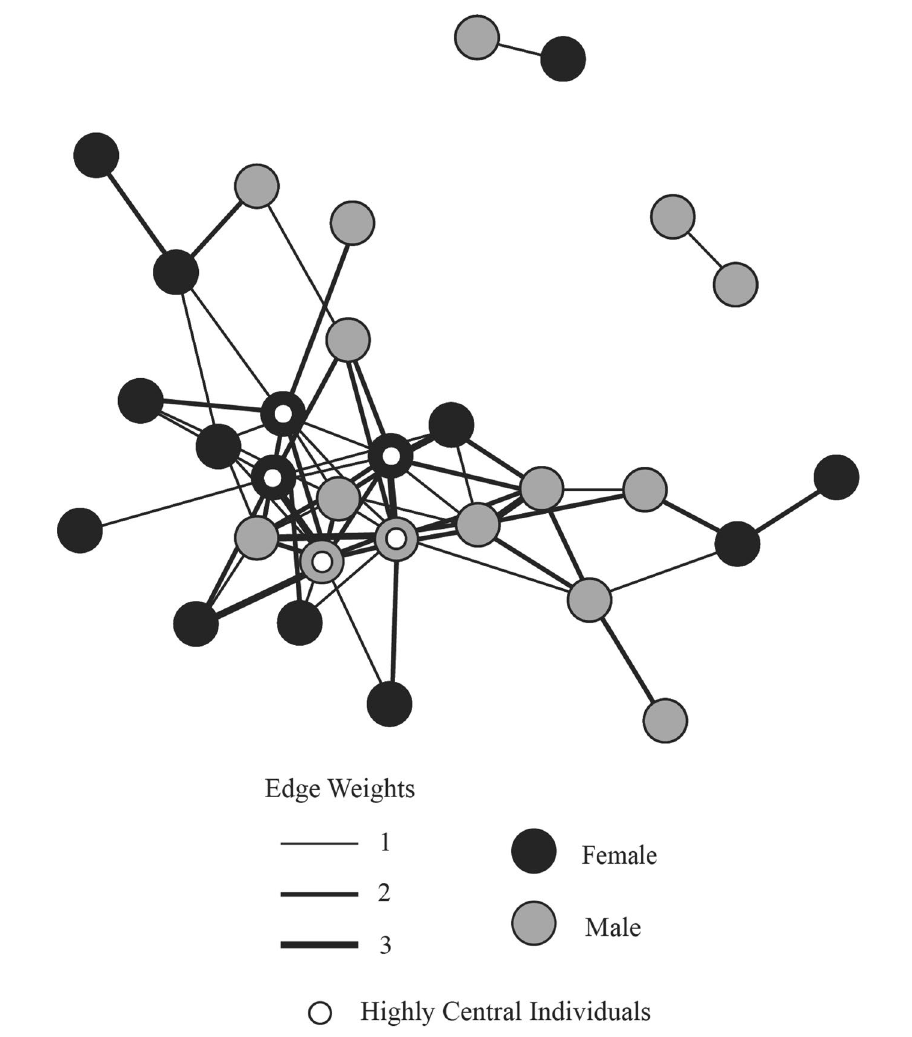
Fig. 2 Site 1 social network (n = 30 individuals). Each circle is a node and represents a unique individual, with males in gray and females in black. Highly central individuals (degree ≥ 10) are represented by nodes with white circles. Lines between nodes are network edges, representing social links between lizards. Edges are weighted by the number of interactions that were observed between a pair of individuals. For social links that occurred only once, weight = 1, for those occurring 2–5 times, weight = 2, and for those occurring 6–14 times, weight =